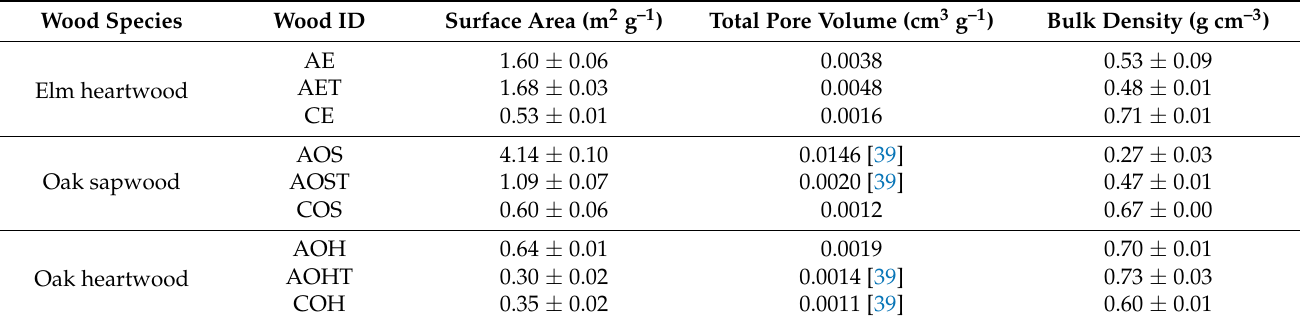
Figure 3. SEM images of air-dried archaeological oak samples: ( A ): untreated sapwood; ( B ): sapwood treated with MTMS; ( C ): untreated heartwood; ( D ): heartwood treated with MTMS. Table 2. Average values of the surface area, total pore volume and bulk density of contemporary and archaeological wood samples untreated and treated with MTMS; ± standard deviation, archaeological untreated elm heartwood (AE), oak sapwood (AOS) and oak heartwood (AOH), archaeological MTMS-treated elm heartwood (AET), oak sapwood (AOST)